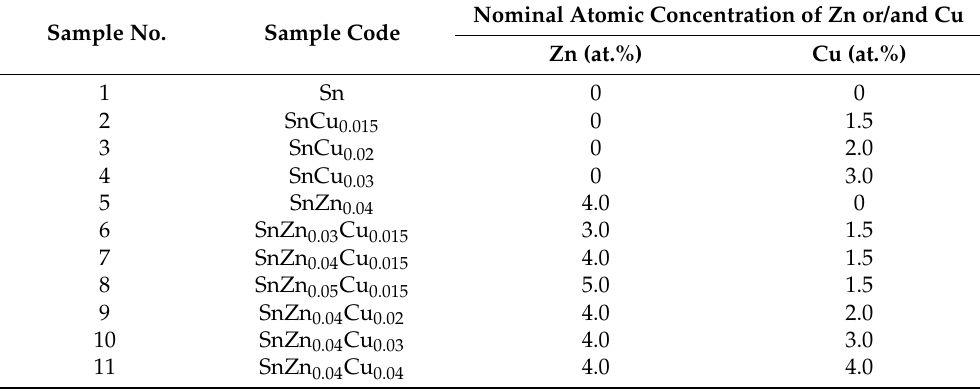
Table 2. Nominal atomic concentration of Zn or/and Cu in the samples. Sample No. Sample